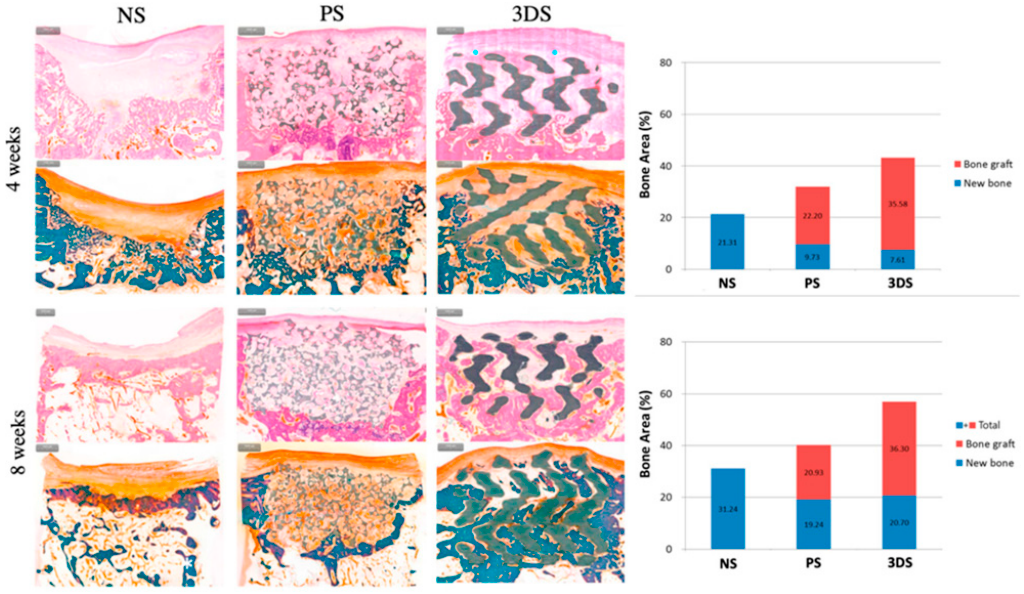
Figure 2. Histomorphometric evaluation at 4 and 8 weeks. The 3DS group showed a higher value of total amount of bone than PS and NS groups at 4 weeks. At 8 weeks, the greatest total amount of bone was in the 3DS group, followed by the PS and NS groups. 3DS: 3D-printed HA/TCP; PS: Particle-type substitute (OSTEON 3, Genoss ® , Suwon, Korea); NS: Untreated defect [43]. The micro-CT assessment showed that the mineralized tissue was greater in defects filled with 3D-printed HA scaffolds compared to the unfilled defect, which was deposited with newly formed mineralized tissue as early as the fourth week [41]. The finding from the group of 3D-printed HA with the oxidized RAM supplement showed a greater bone volume/radiographic region of interest [42]. The study by Kim et al. also reported an increased total amount of bone observed in the 3D-printed HA/TCP group compared to the untreated group [43] as shown in Figure 3. 3D-printed β -TCP-based scaffolds, coated with either DIPY, rhBMP-2 or bdECM, also reported new bone tissue ingrowth at the osseous defect [38–40,44,45]. For early gene expression in the mandibular osseous defects in vivo, 3D-printed HA/PLGA showed significant upregulation of vascular endothelial growth factor (VEGF) and RUNX2 in the 3D group with oxidized RAM supplement [42], and type 1 collagen (Colla1), VEGF and core-binding factor alpha-1 (Cbfa1) relative to the control group [41]. A study by Lee et al. reported greater expression of genes and proteins related to ossification, which were Colla1, osteocalcin and RUNX2 in 3D-printed β -TCP/PCL coated with bdECM and ADSCs aggregates